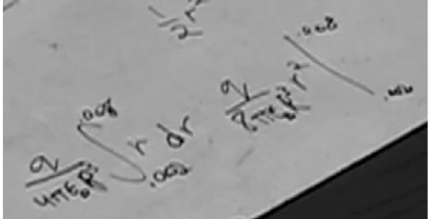
FIG. 10. Joe ’ s version of the analytical derivation game to solve the electrostatics